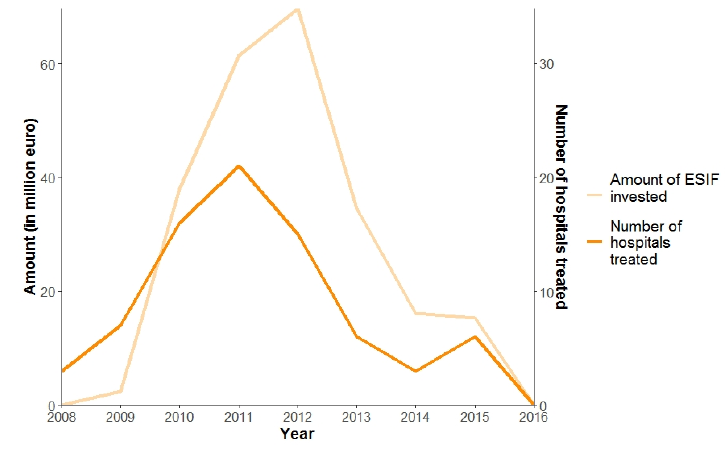
Figure 2: Development of absorption of ESIF in